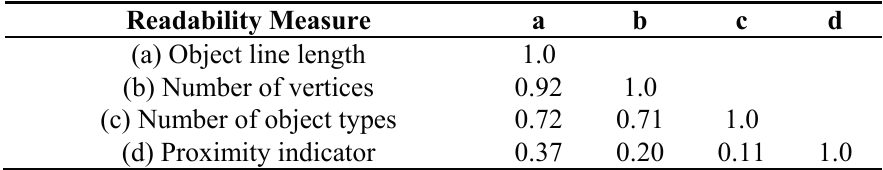
Table 6. Correlations (Equation (10)) between measures. The computations are based on the 175 TS map